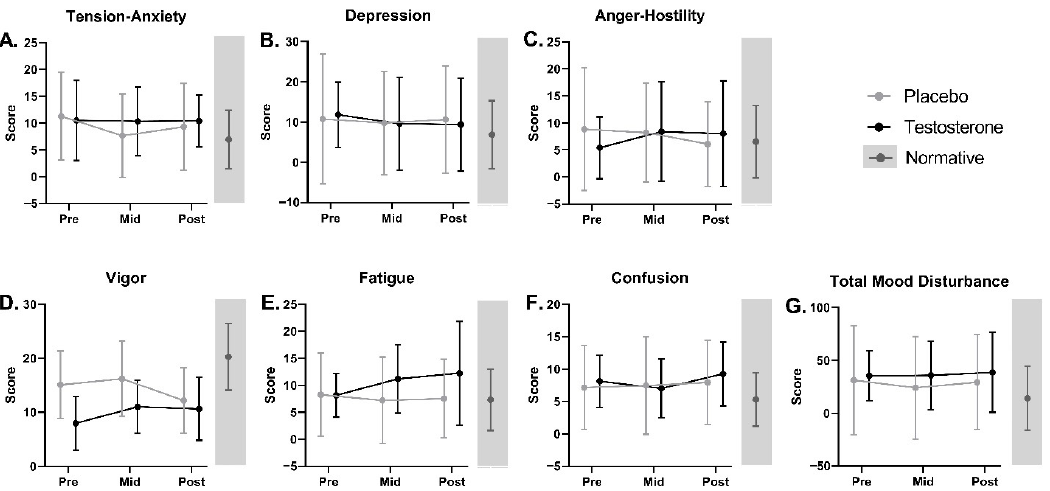
Figure 6. Profile of Mood States—Short Form (POMS) subscale and total scores at pre, mid, and post for cancer patients receiving testosterone or placebo. Average ( ± SD) scores for ( A ) Tension–Anxiety, ( B ) Depression, ( C ) Anger–Hostility, ( D ) Vigor, ( E ) Fatigue, and ( F ) Confusion subscales, as well as ( G ) Total Mood Disturbance score. Average (±SD) normative scores [65], as available, are displayed in gray sidebars to the right of each graph. There were no significant differences between groups or in scores over time for either group after adjusting for multiple testing. Higher scores on presented questionnaires are undesirable and indicate greater symptom severity, with the exception of Vigor ( D ), for which lower scores are undesirable and indicate greater symptom severity.